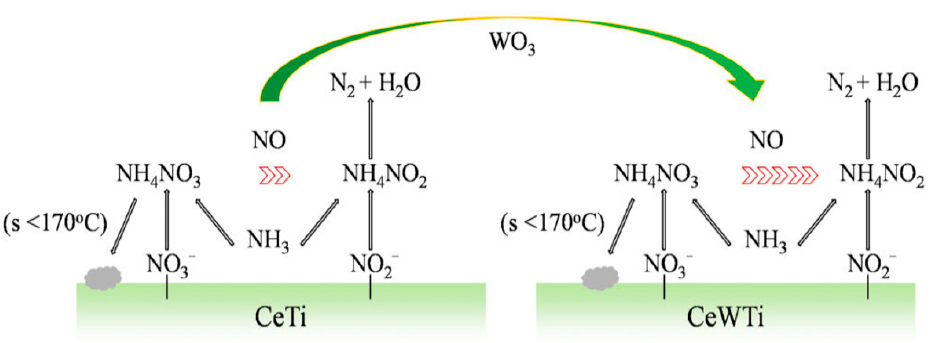
Figure 12. NH 3 -NO/NO 2 SCR reaction routes on CeTi and CeWTi catalysts [85].